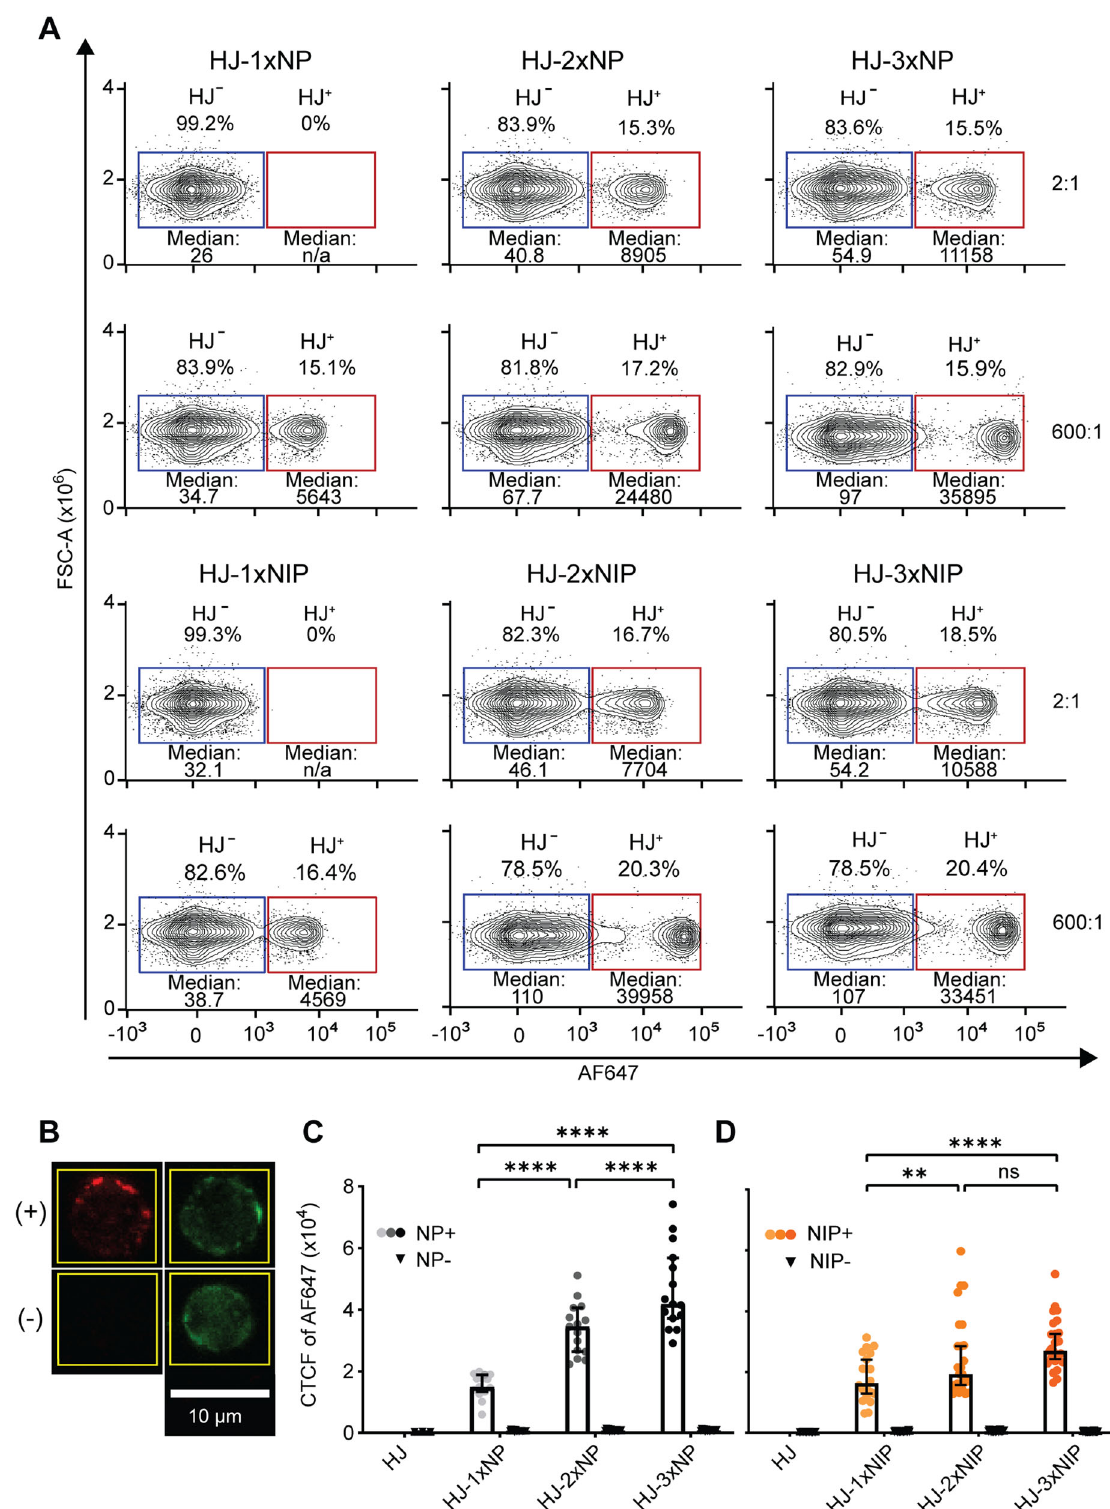
(Fig. 4C). The signal for HJ-1xNIP was below background and no signal was detectable for HJ-1xNP. Importantly, this was seen under condi- of receptor occupancy by HJ-1xNIP, on the order of